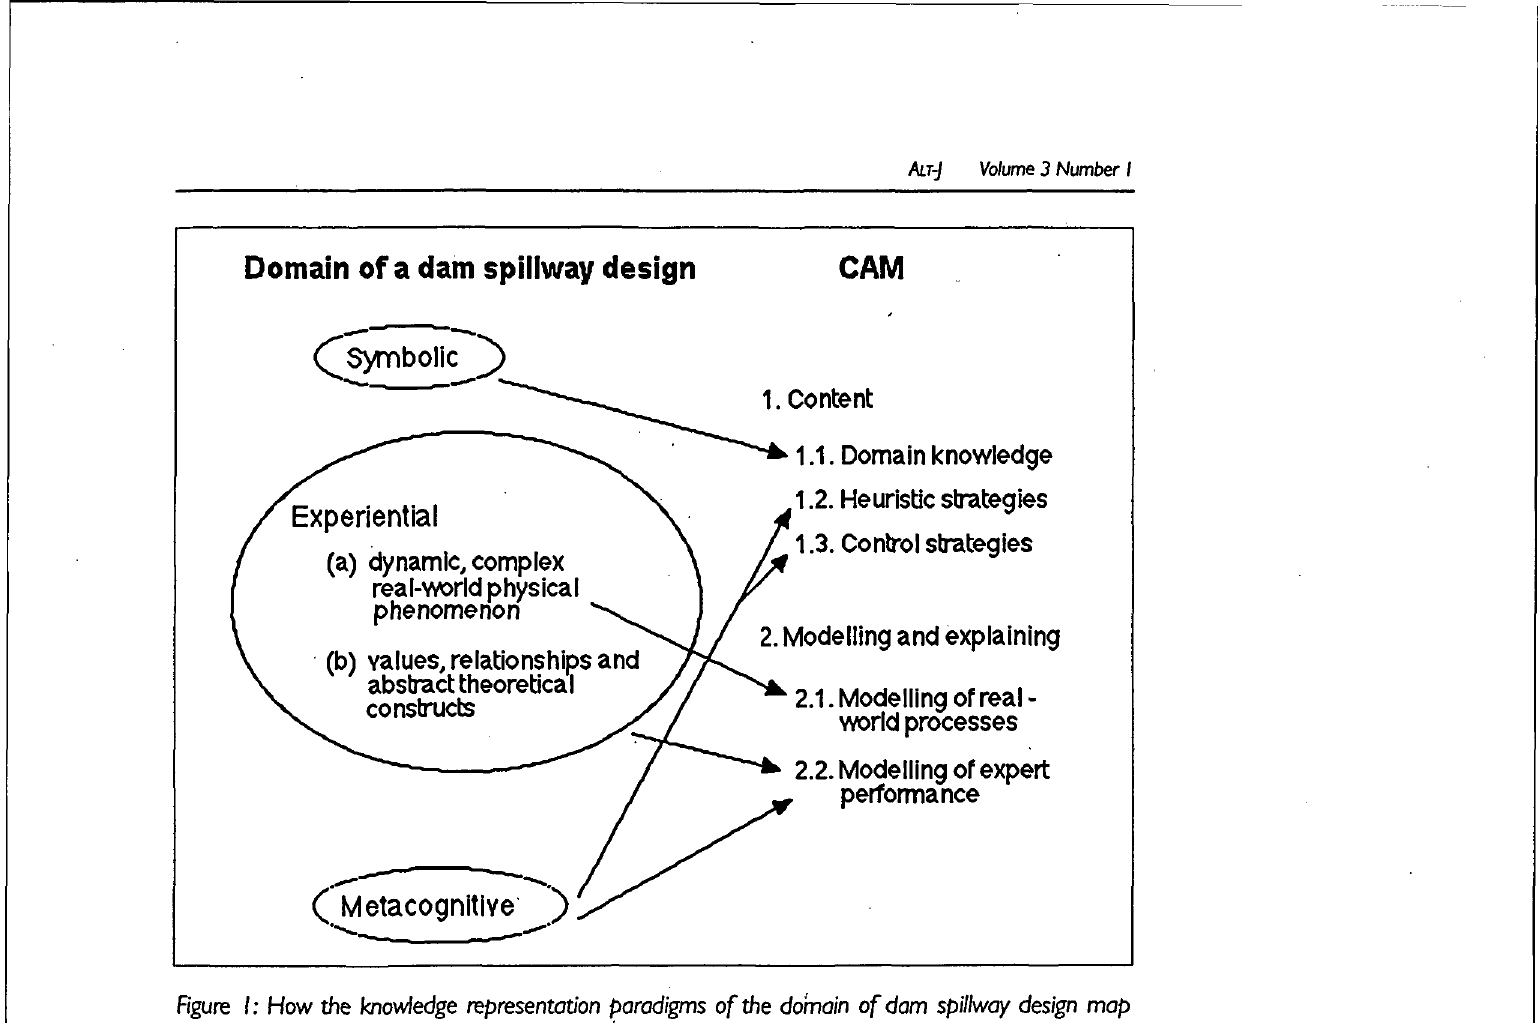
Figure I: How the knowledge representation paradigms of the domain of dam spillway design map onto the types of knowledge recognized by the